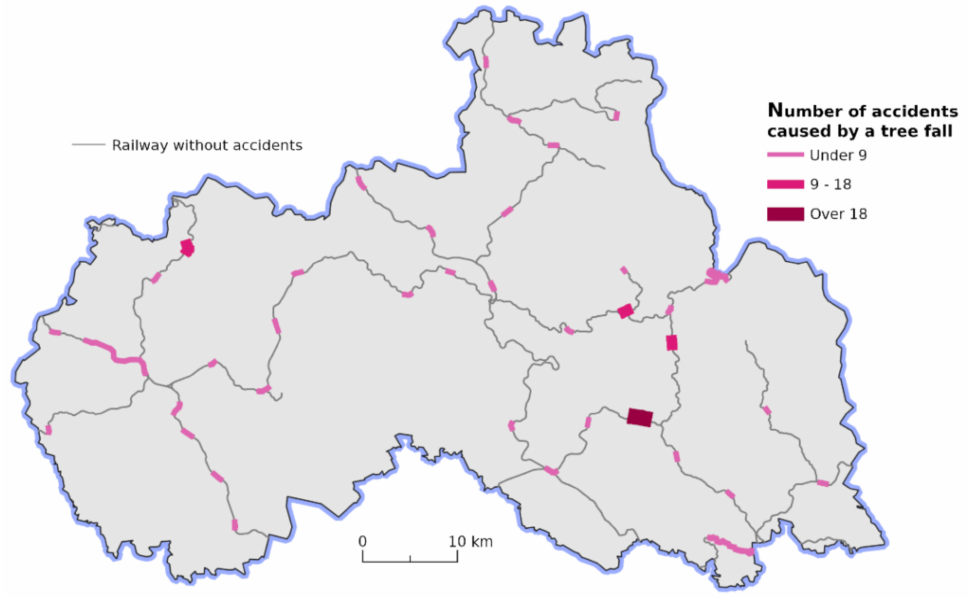
Figure 6. Extraordinary railway events in the Liberec Region caused by fallen trees in